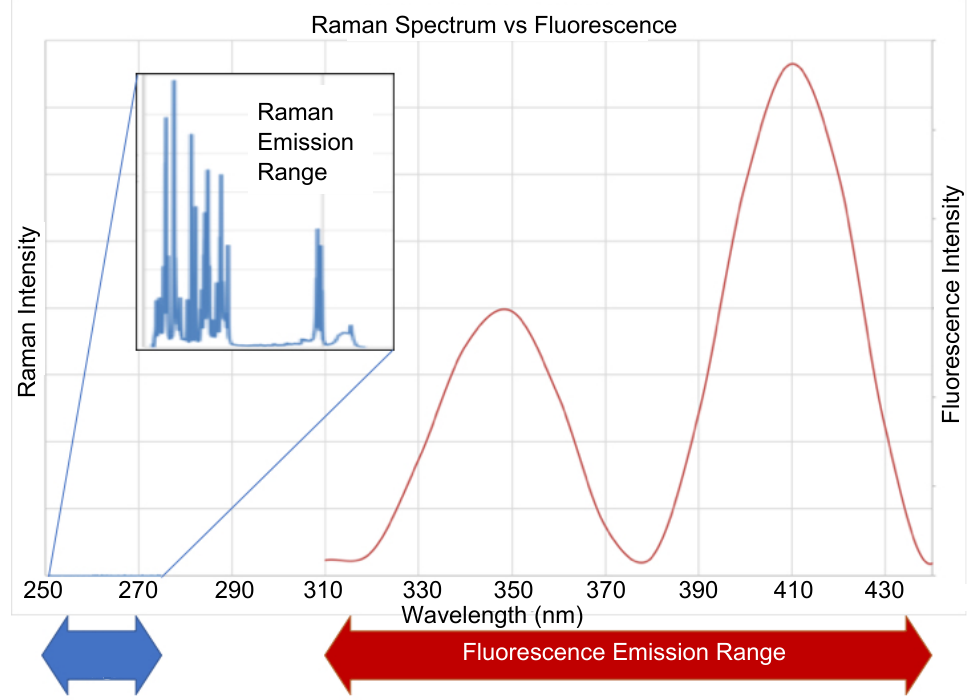
Figure 2. Raman and fluorescence emission ranges for a 250 nm excitation. Reprinted from